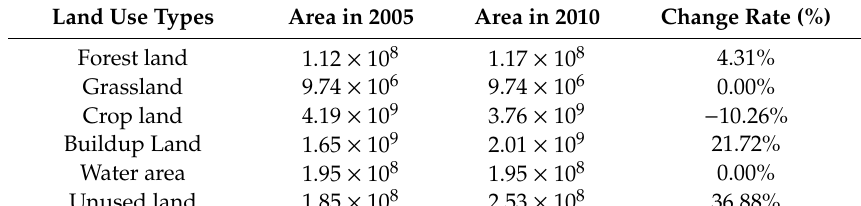
Table 3. Land-use change in Shanghai from 2005 to 2010 (m 2 ).